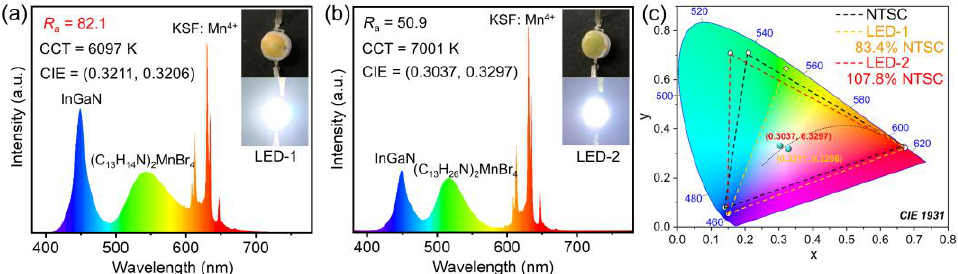
Figure 6. Emission spectrum of w -LEDs based on ( a ) (C 13 H 14 N) 2 MnBr 4 and ( b ) (C 13 H 26 N) 2 MnBr 4 . The insets show the photographs of w -LEDs in the daylight (top) and working at 20 mA (bottom). ( c ) CIE 1931 colour coordinates of fabricated LED-1 (orange dotted line), LED-2 (red dotted line) and the NTSC standard (black dotted line).